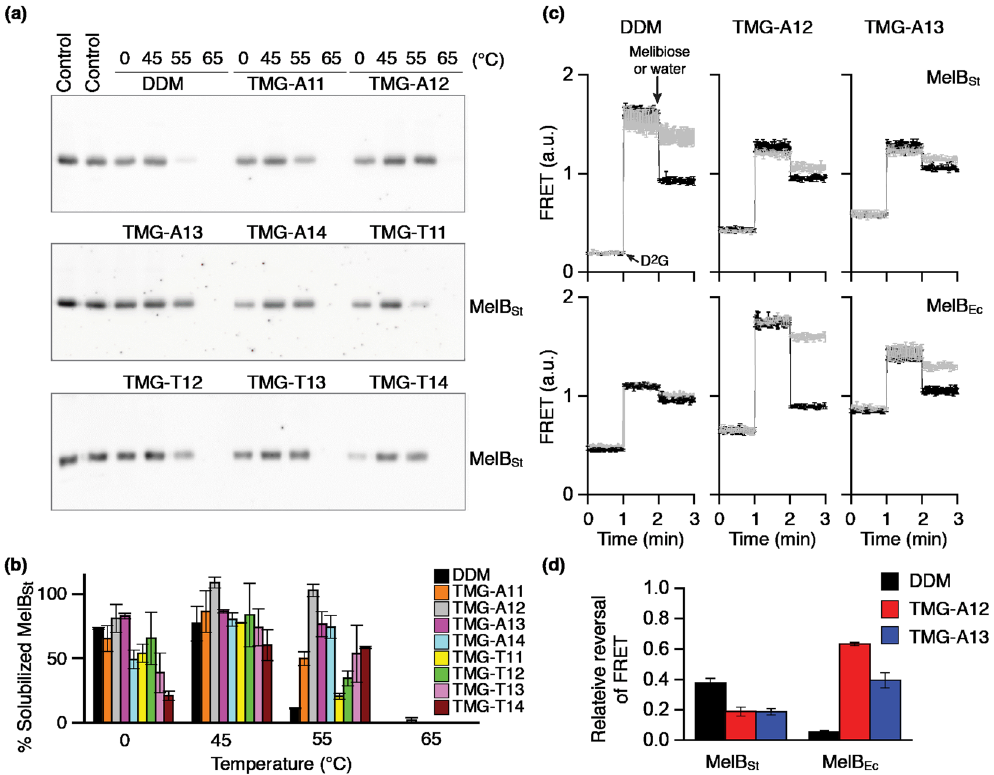
Figure 6. Thermostability and functionality of MelB St solubilized in DDM or individual novel agents (TMG-As: TMG-A11, TMG-A12, TMG-A13 and TMG-A14; TMG-Ts: TMG-T11, TMG-T12, TMG-T13 and TMG- T14). E. coli membranes containing MelB St were mixed with the indicated detergent, and then kept at 0 °C or an elevated temperature (45, 55, or 65 °C) for 90 minutes. ( a ) Western blott analysis. The amount of soluble MelB St after ultracentrifugation was detected by penta-His-HRP antibody. The protein samples were initially separated on SDS-15%PAGE gels. ( b ) Histogram. The density representing the soluble MelB St in individual detergents detected in panel ( a ) was measured by ImageQuant software and expressed as a percentage (%) relative to that present in the untreated membrane sample ( b ). Error bars, SEM, n = 3. ( c ) MelB Trp → D 2 G FRET reversal functional asssay. Sample preparations and FRET measurements are described in the Methods. The FRET signals were monitored over time. D 2 G at 10 μ M was added at the 1-min time point and melibiose (black trace) at a saturating concentration added at the 2-min time point. Control experiments were carried out by adding water (gray trace) instead of melibiose at the 2-min time point. ( d ) Relative values for FRET reversal were obtained by calculating fluorescent intensity decrease (at 2-min point)/increase (at 1-min